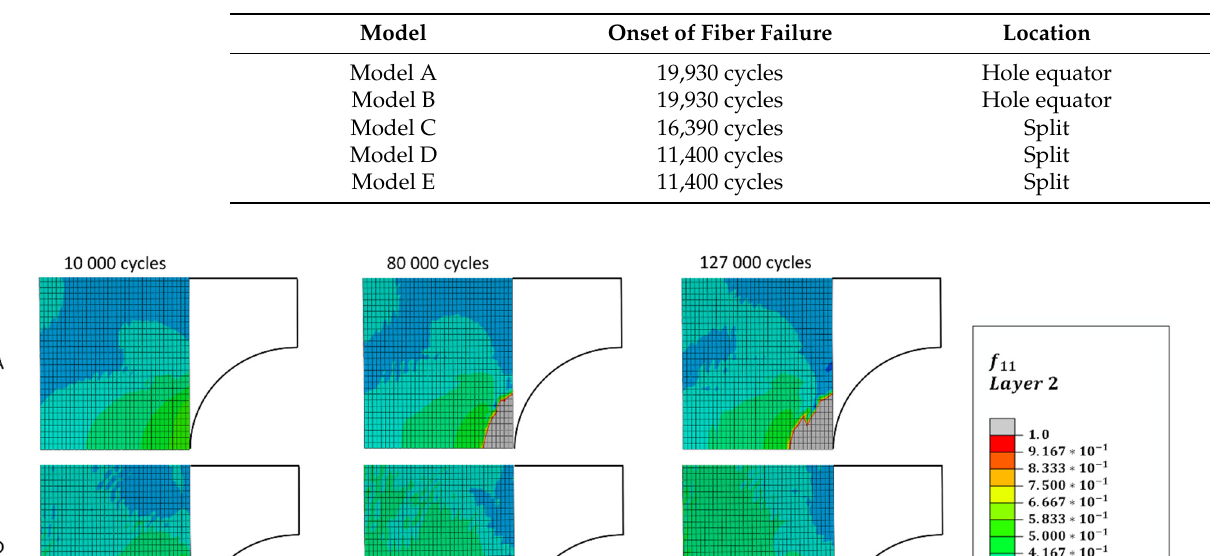
Table 6. First fiber failure in models A–D.